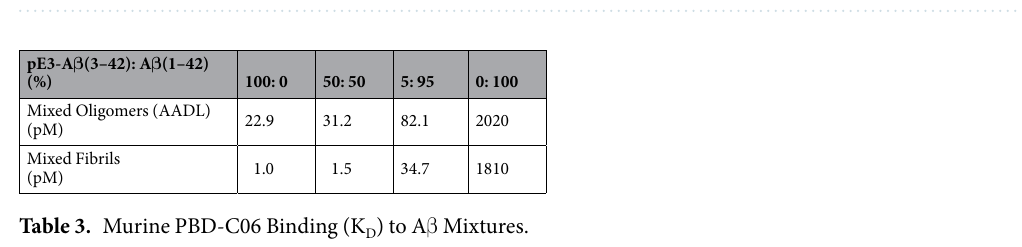
Table 2. Murine PBD-C06 Binding to Soluble A β Species.